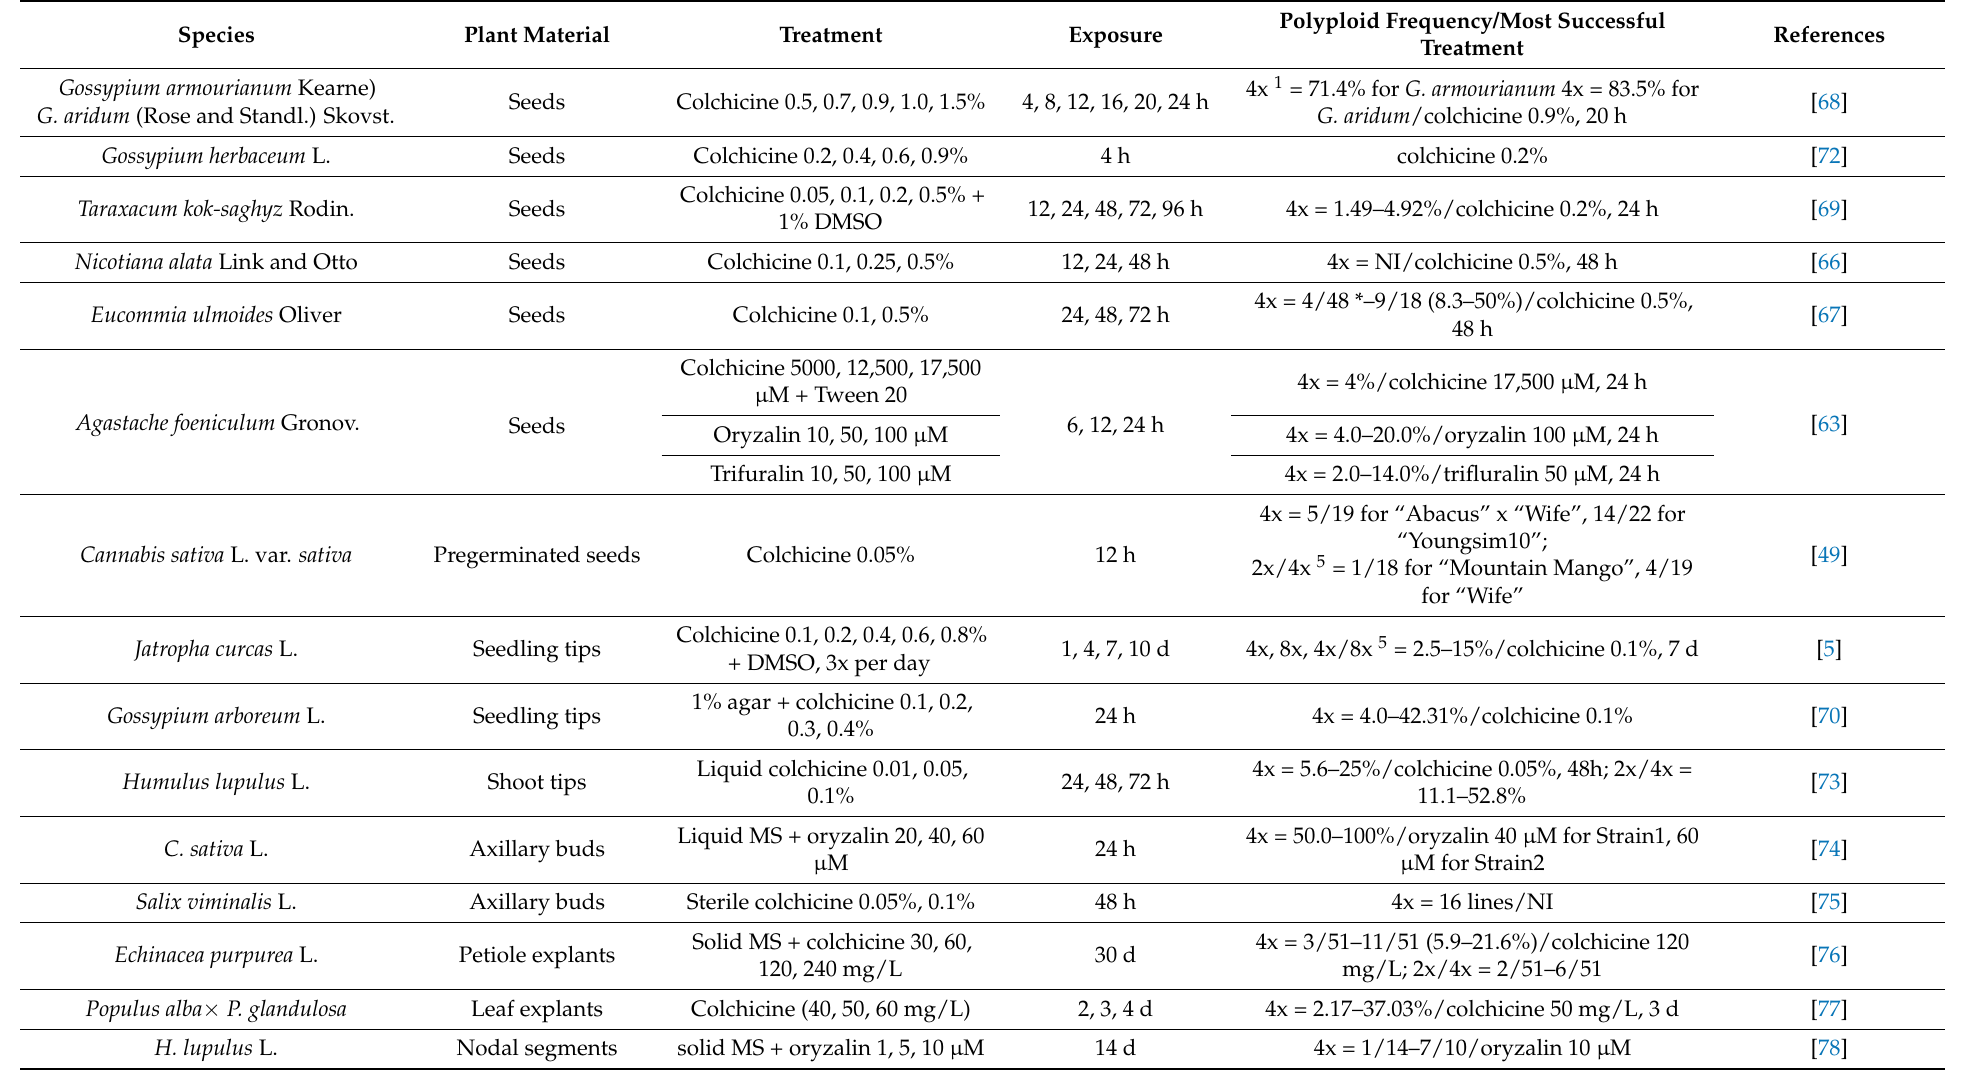
Table 2. Polyploid induction of industrial plants using various plant materials, antimitotic agents, concentration and exposure